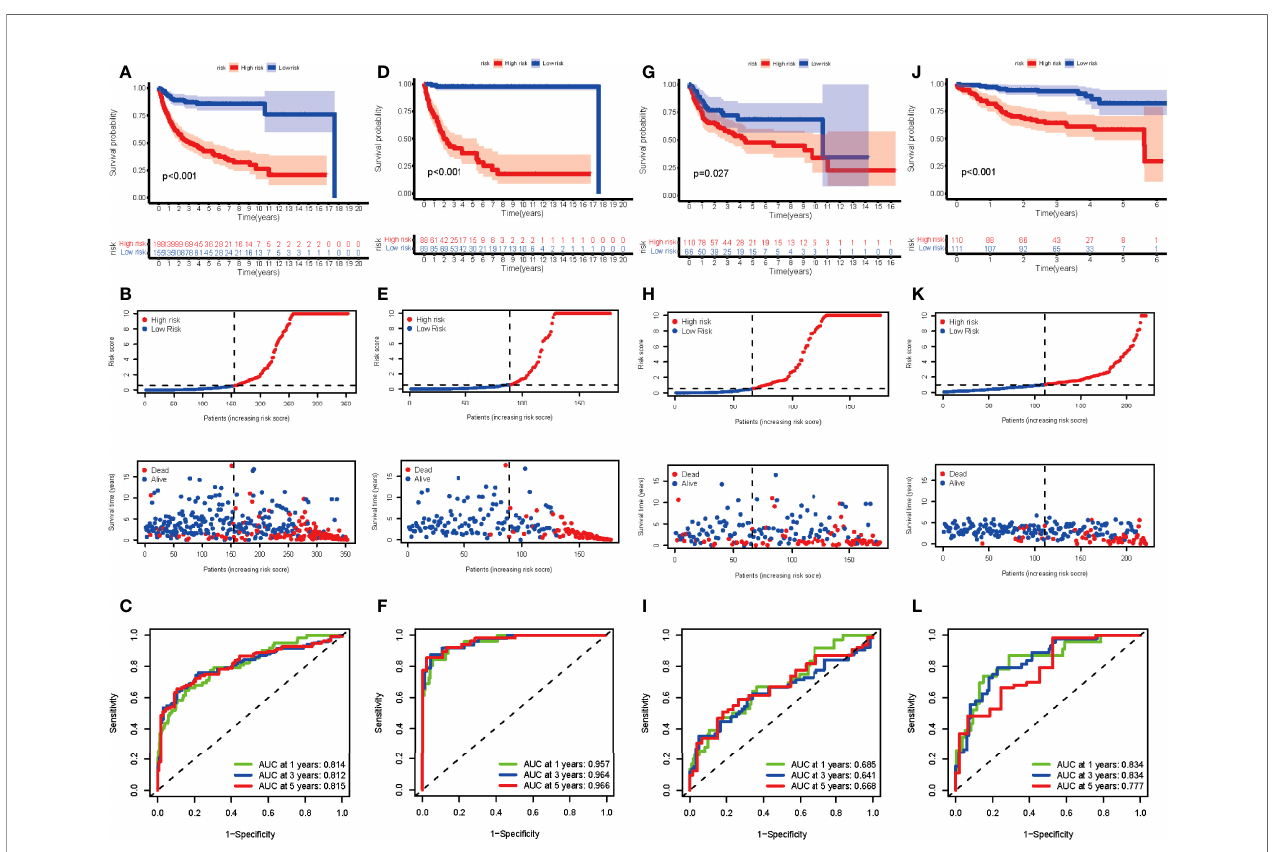
FIGURE 4 | Evaluation of the risk score in the entire, training, test, and external validation cohort. (A , D, G , J) K-M curve of the entire, training, test, and external validation cohort, respectively. The p -value is <0.001, <0.001, 0.027, and <0.001, respectively. (B , E , H , K) The risk curve and survival status curve of each cohort, respectively. (C , F , I , L) ROC with AUC at 1, 3, and 5 years of each cohort,